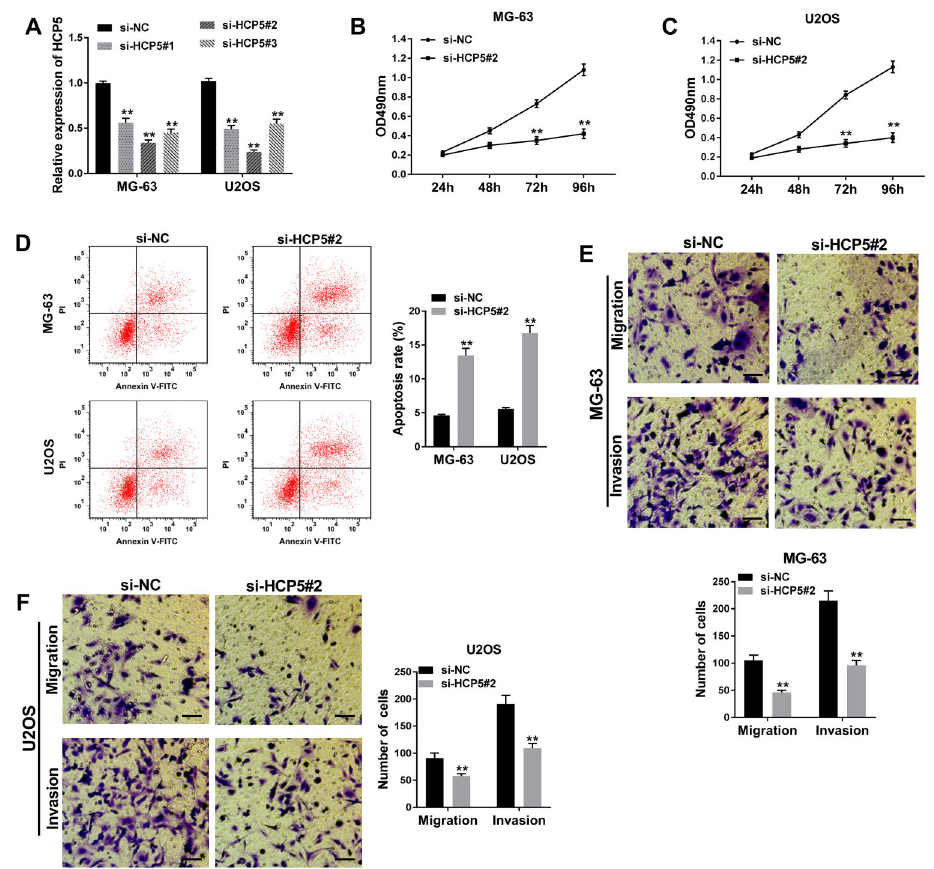
Figure 2. HCP5 knockdown suppressed proliferation, migration, and invasion, and promoted apoptosis in osteosarcoma (OS) cells. A , The expression of HCP5 in MG-63 and U2OS cells transfected with si-NC, si-HCP5#1, si-HCP5#2, or si-HCP5#3 was measured by qRT-PCR. B and C , Cell proliferative capacity was evaluated by MTT assay. D , Cell apoptosis was detected 48 h after transfection by fl ow cytometry. E and F , Cell migration and invasion were con fi rmed by transwell assay in MG-63 and U2OS cells (100 (cid:2) , scale bar: 50 m m). Data are reported as means ± SD. ** P o 0.01 (Student ’ s t -test and